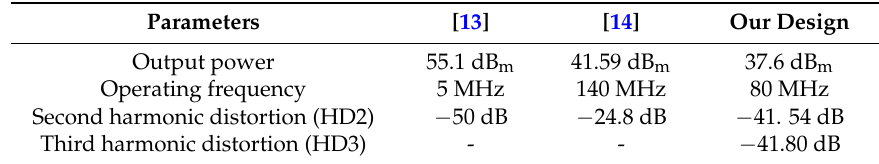
Table 2. Performance comparison of our linearizer and a previously-reported design, including pulse-echo performances with ultrasound